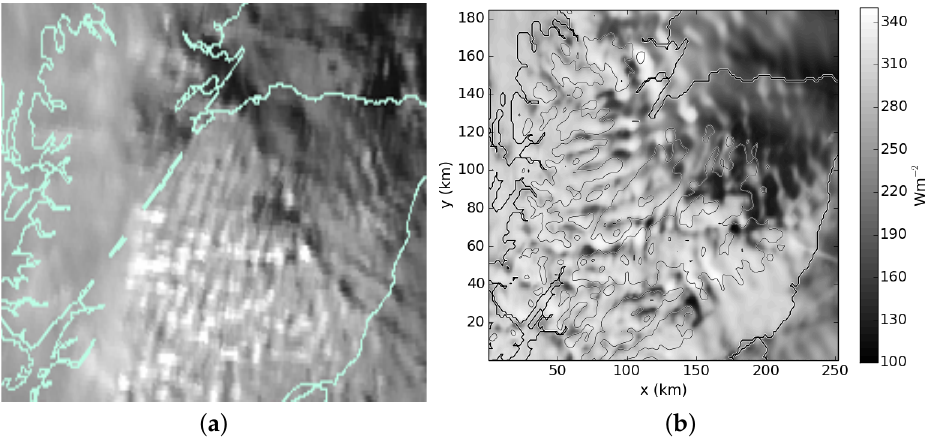
Figure 7. ( a ) Meteosat Second Generation visible satellite image at 10 UTC 6 March 2015, cropped over the Grampians 3DVOM domain region; and ( b ) UKV TOA shortwave radiative flux cropped to the same area. Note, no effort has been made to synchronise the shading scales of the two panels, so they may only be compared in a qualitative